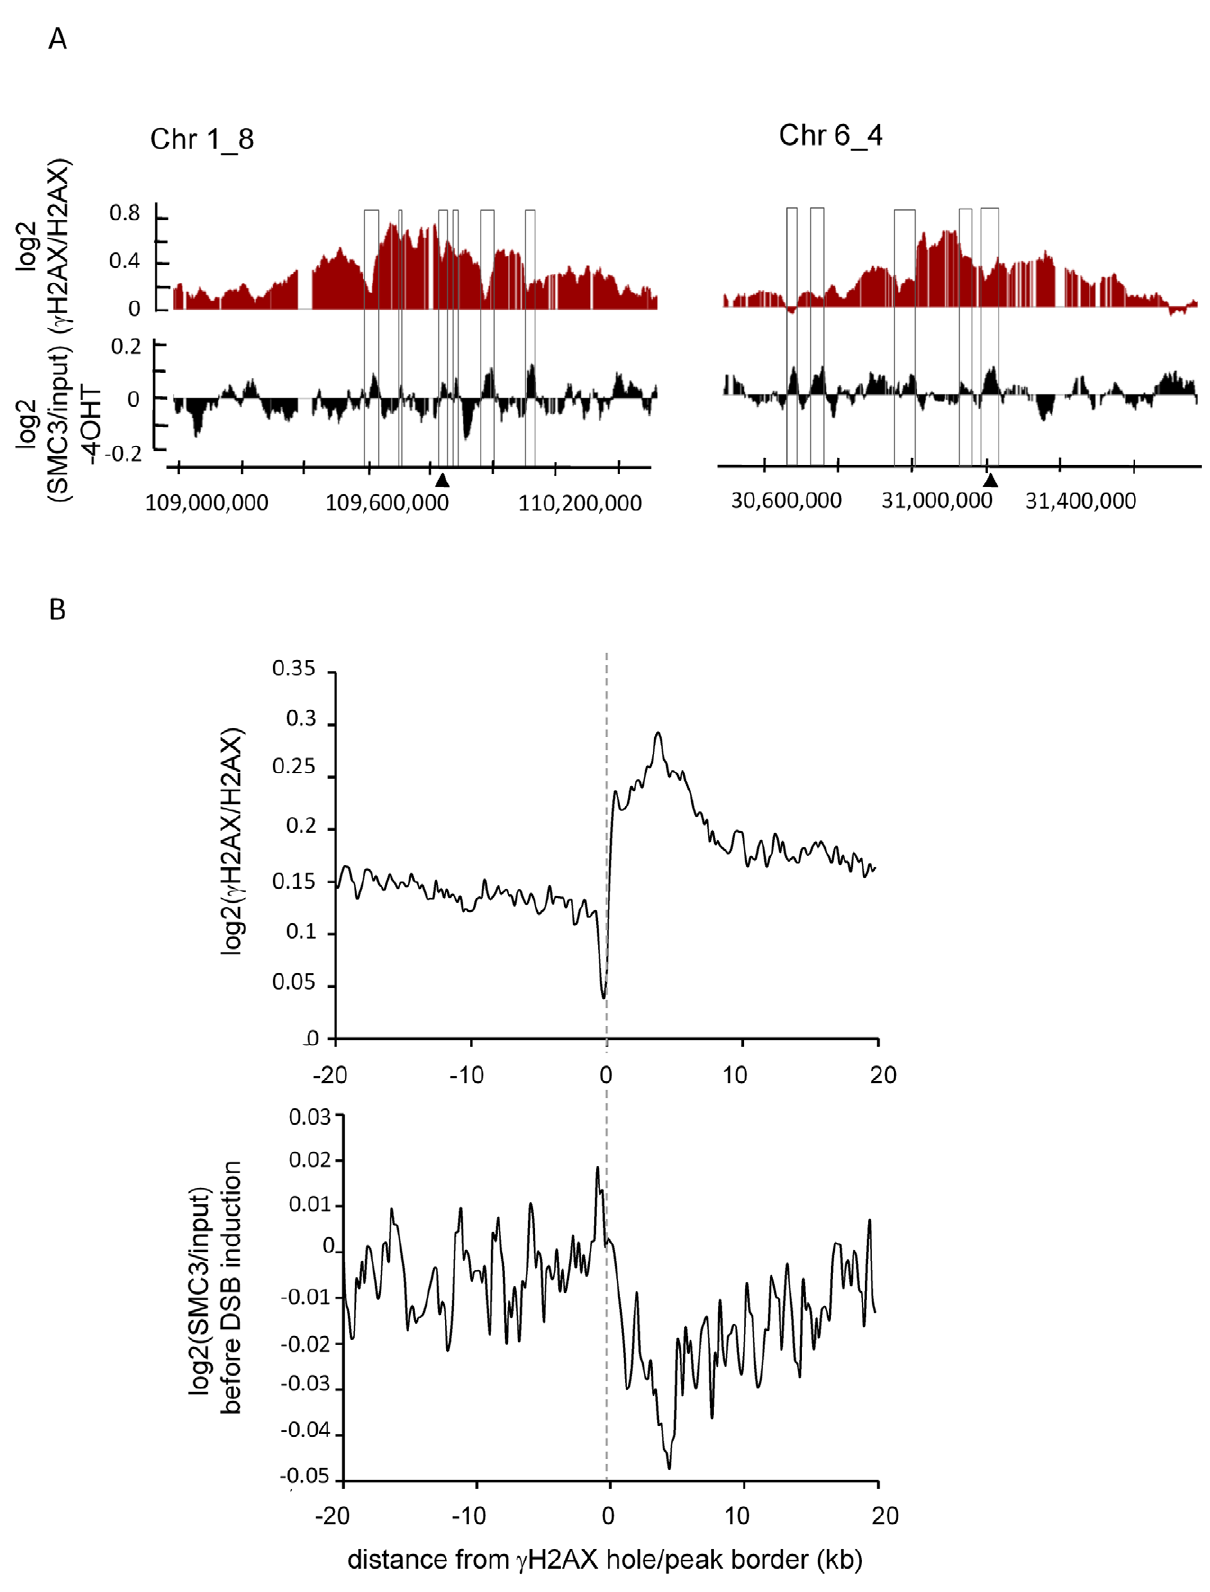
Figure 2. SMC3 counteracts c H2AX. A, Detailed views of the c H2AX/H2AX signal after 4OHT treatment (red) and the SMC3/input signal before 4OHT treatment (black) around two Asi SI sites (indicated by arrows), expressed as log2 and smoothed using a 500 probes sliding window. B, Regions depleted in c H2AX inside the c H2AX domains were identified using the algorithm detailed in [10] (applied on the average of two 4OHT-induced c H2AX/H2AX ChIP-chip studies). 534 ‘‘hole’’ borders were aligned and overlaid, right and mirror left borders are combined. Profiles are shown for